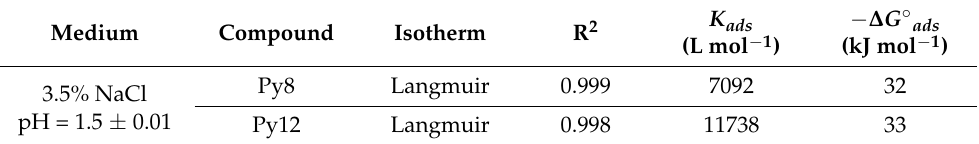
Figure 8. Langmuir adsorption isotherm for the adsorption of Py8 and Py12 on the EN3B mild steel surface in 3.5% NaCl solution at pH 1.5. Table 6. Parameters calculated from the Langmuir adsorption isotherm for the interaction of inhibitors with the mild steel surface.